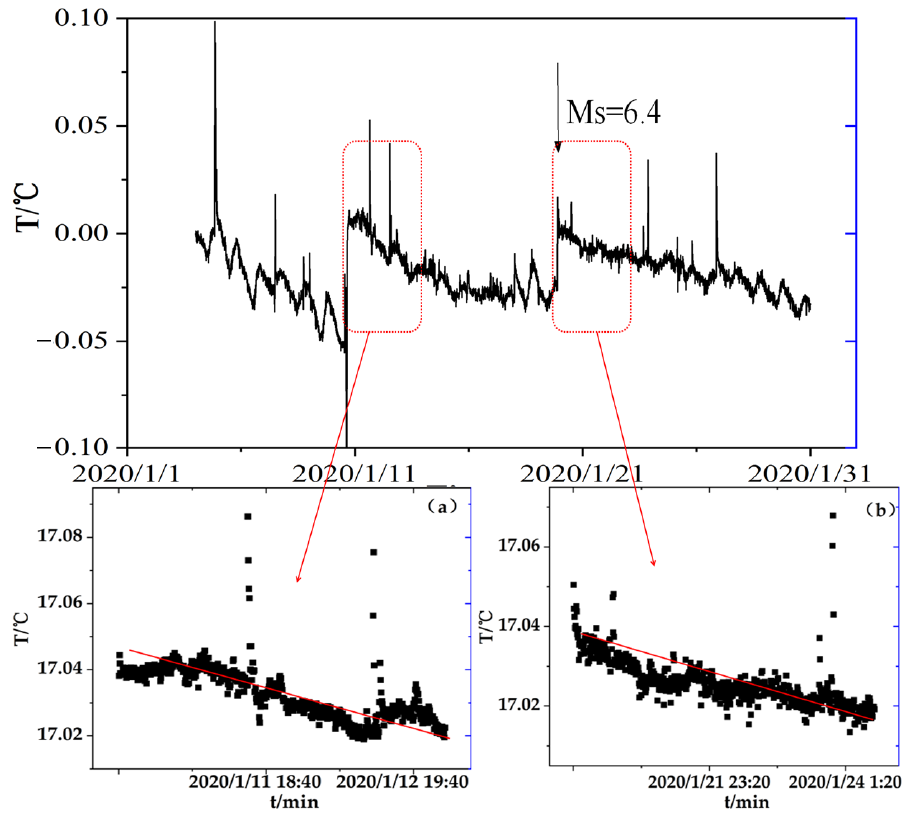
Figure 7. Comparison of the coseismic phenomenon of ground temperature at the 33.38 m layer at XKE and comparison of the temperature attenuation curve before ( a ) and after ( b ) the earthquake.